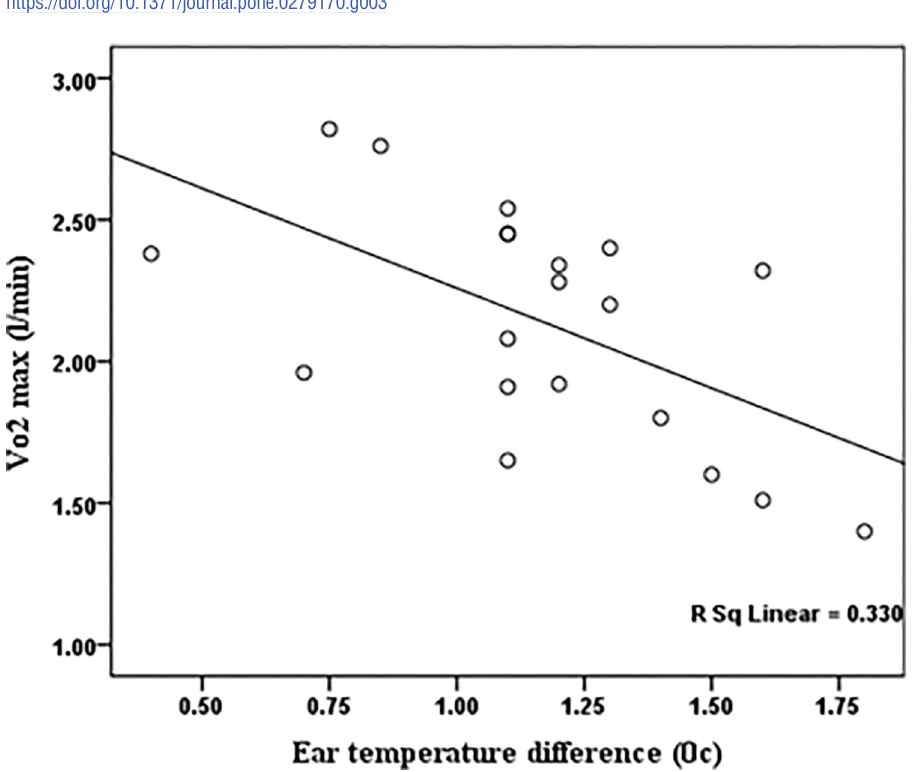
Fig 4. The scatter plots of the VO 2 max compared to the ear temperature difference before and after walking on a treadmill in the warm air condition. https://doi.org/10.1371/journal.pone.0279170.g004 PLOS ONE | https://doi.org/10.1371/journal.pone.0279170 December22,